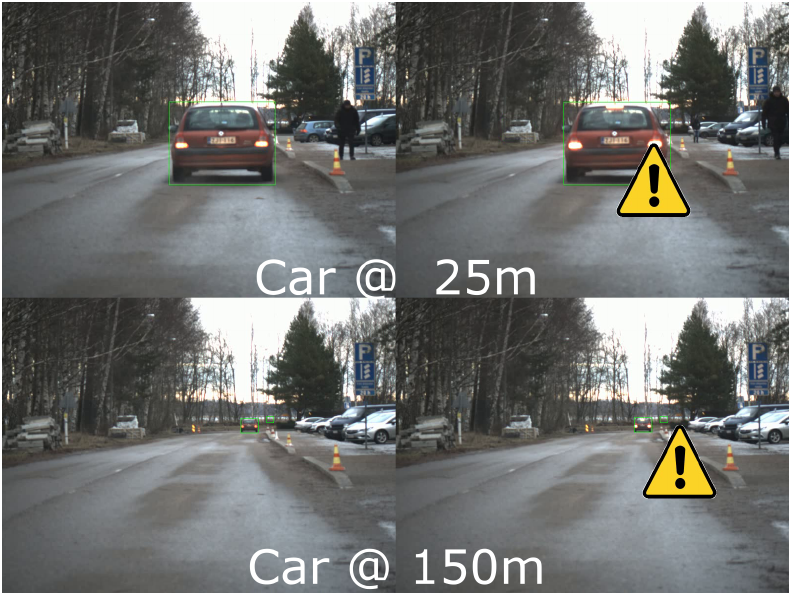
Figure 8. Range test with preprocessing at 25 m and 150 m, warning triangle indicating detected brake lights.